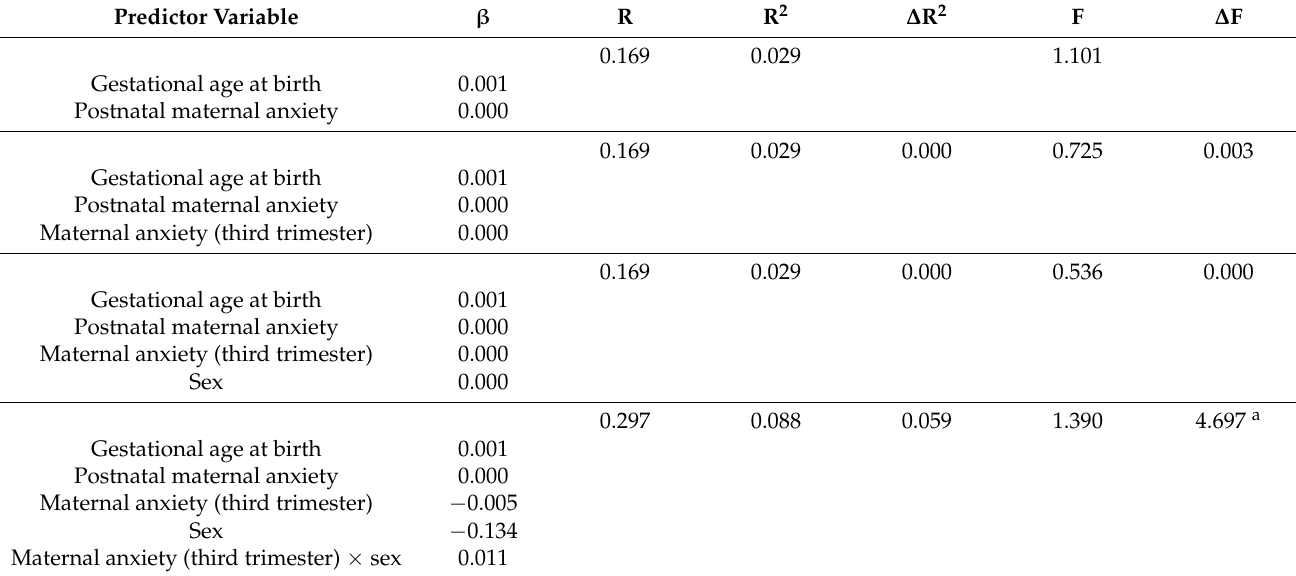
Table 5. Linear regression model of methylation level of IGF2/H19 -CpG6.